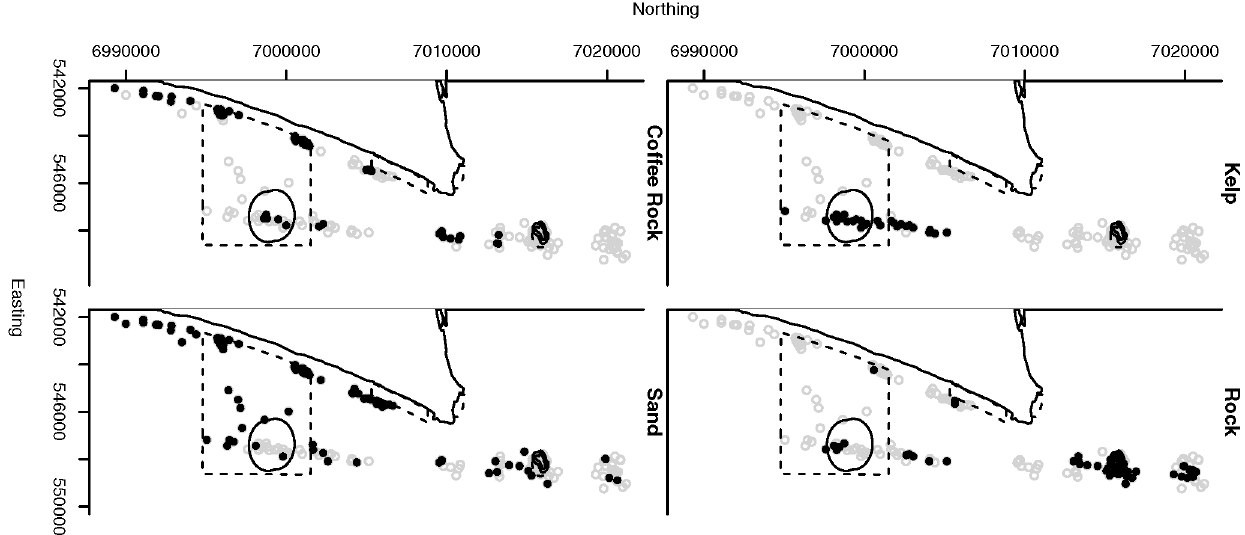
Fig 1. BUV site locations where habitat types were present. The open grey circles indicate sites where that habitat variable did not cover at least 5% of the site and solid black circles indicate sites where that habitat covered at least 5% of the site. The solid line indicates the Green:old areas while the broken line indicates Green:new areas. Sites outside the bounded areas are open to fishing. MNP04 is the green area in the North and MNP10 in the South. The easting and northing axes are measured in units of